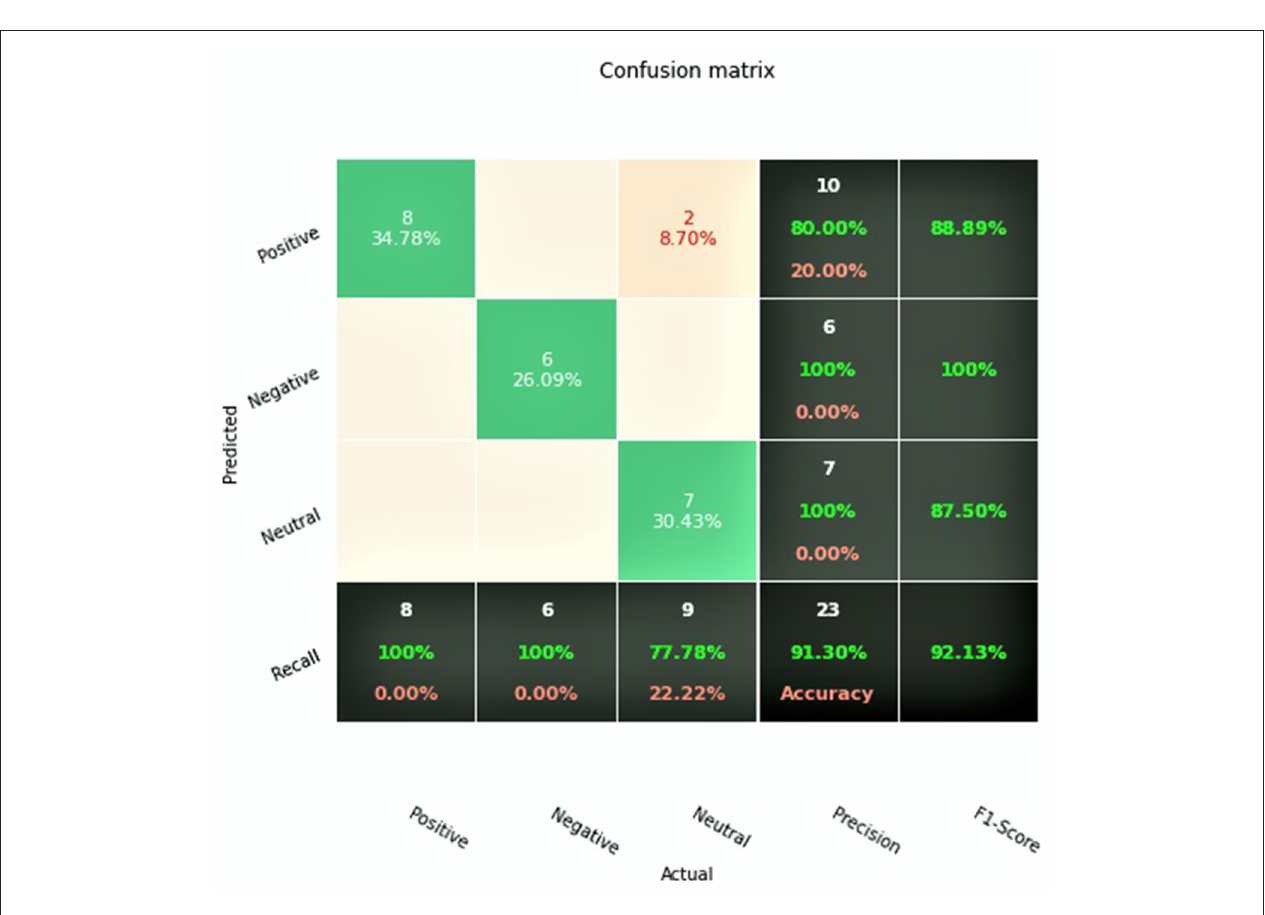
FIGURE 2 | Confusion matrix for